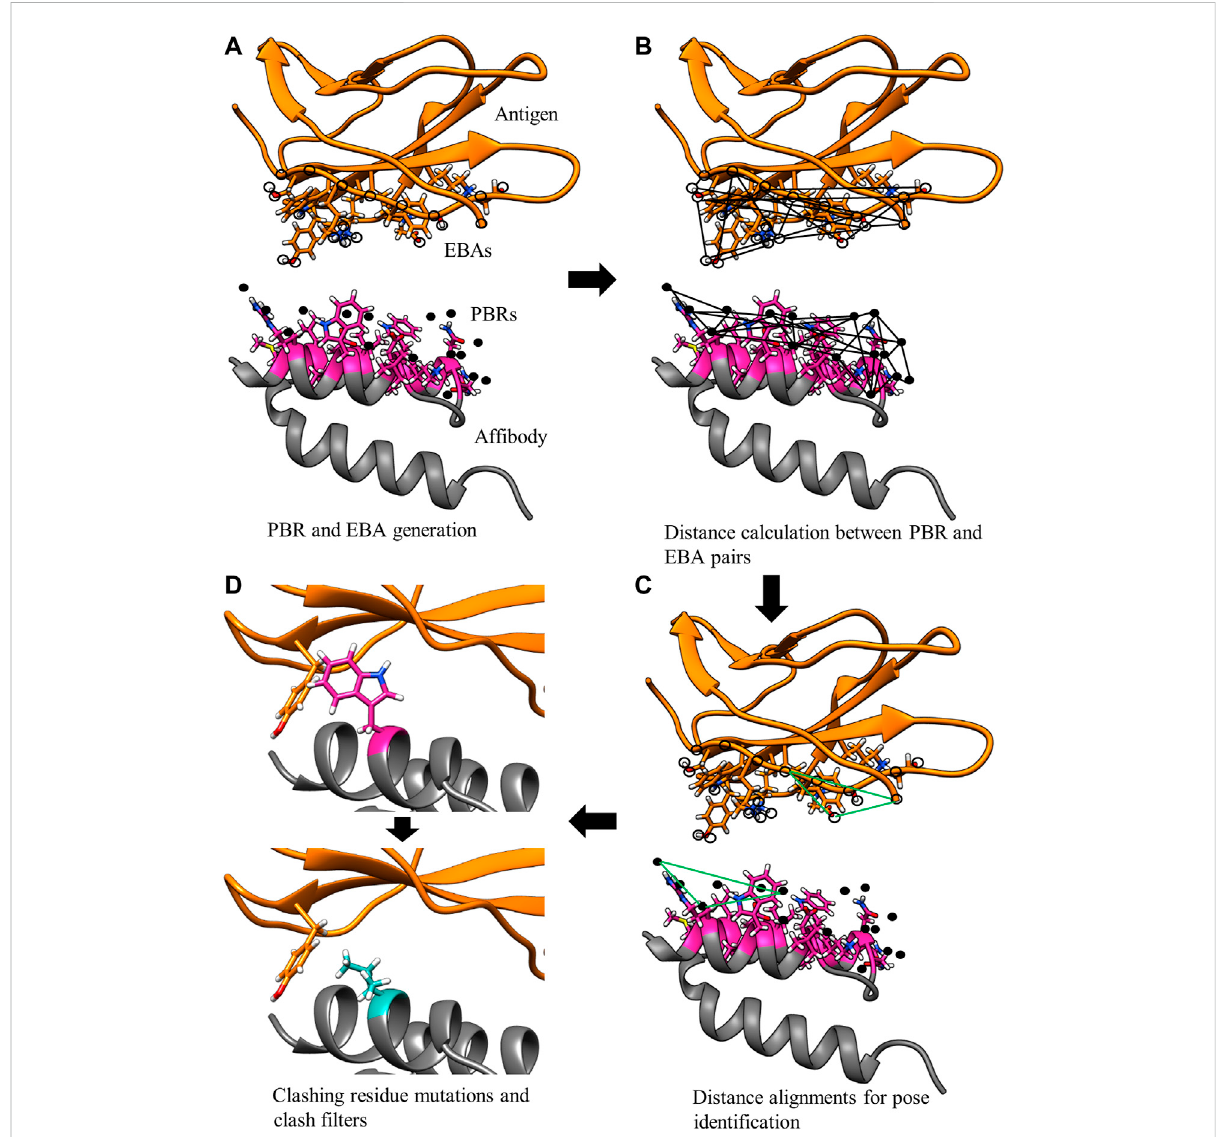
FIGURE 2 MutDock work fl ow. MutDock can be divided into two main steps: pose identi fi cation (panels A – C) and pose validation (panel D). Step (A) PBRs areidenti fi edforallparatoperesiduesandallotherrotamersofvariableresidues(showninpink).Similarly,EBAsareidenti fi edforallepitoperesidues. Step (B) Pairwise distance calculations within the sets of PBRs and EBAs. Step (C) Pairwise distance matching between PBR pairs and EBA pairs to identify groups of compatible low entropy interactions. Step (D) Each pose from Step C is passed through steric clash fi lters, and clashing variable side chains are